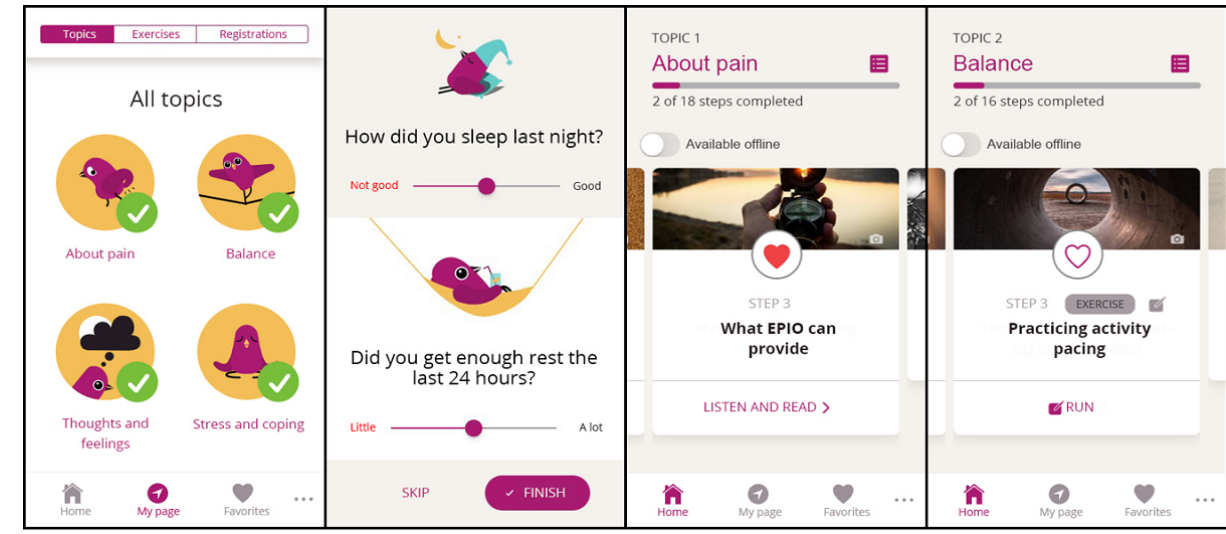
Figure 5. Example screenshots from the EPIO intervention. From left: (1) start page, (2) selective registrations, (3) module about pain, and (4) exercise